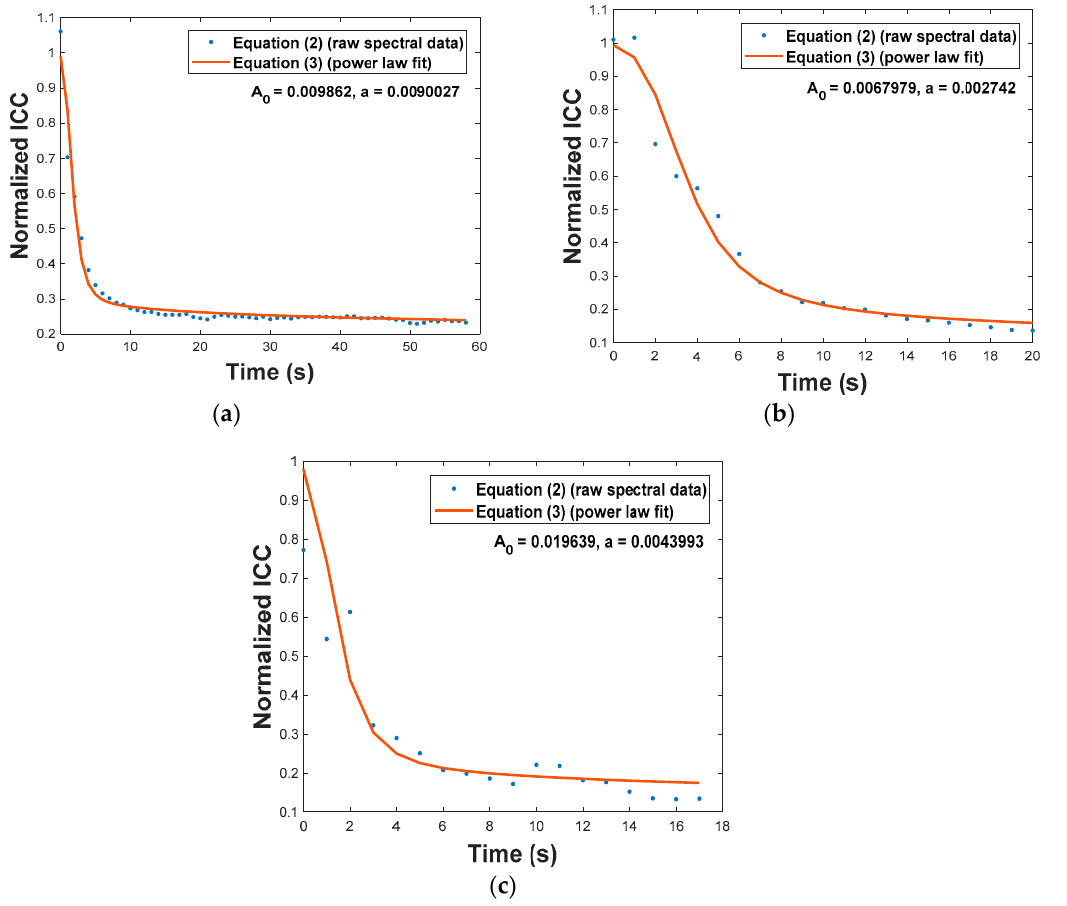
Figure 7. Normalized ICC decay of embedded FBG sensors during HEL strikes (recovery after tests not shown): ( a ) FBG slightly degraded, ( b ) FBG moderately degraded, and ( c ) FBG severely degraded.